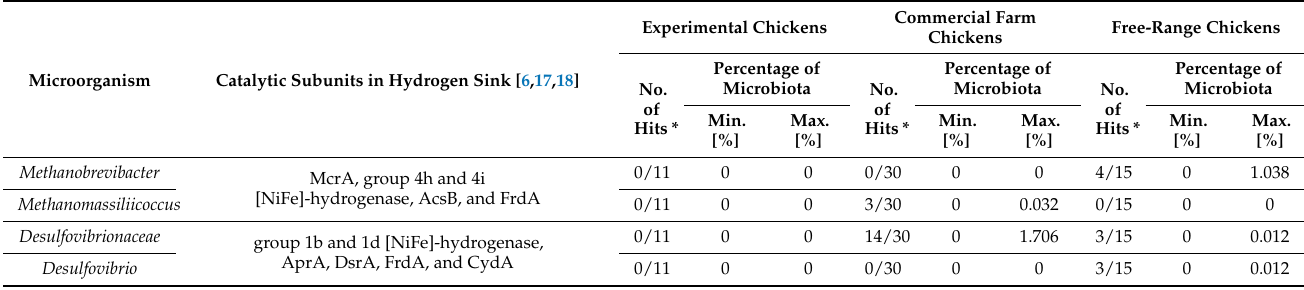
Table 1. The abundance of selected hydrogen consumers in the total microbiota of samples grouped according to the chicken rearing